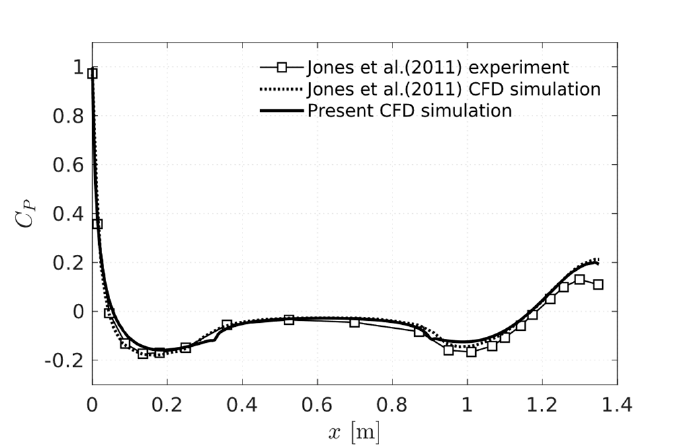
Figure 10. Pressure coefficient along the model submarine hull from present simulation and experi-